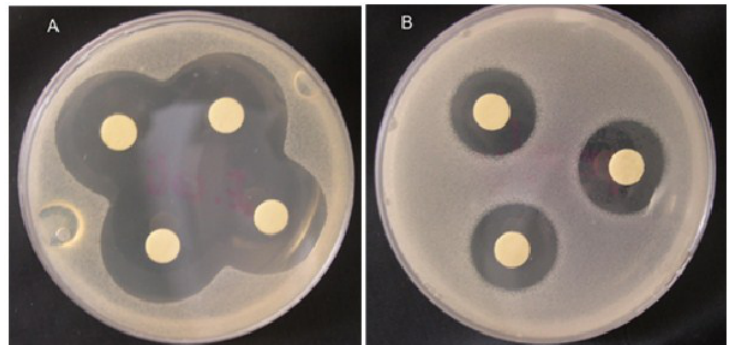
Figure 9. Inhibition zones obtained by the methanolic extract of Corallina officinalis against ( A ) E. coli and ( B ) E. faecalis on Tryptic Soy Agar (TSA) media. Adapted from Taskin et al. [119], an open-access